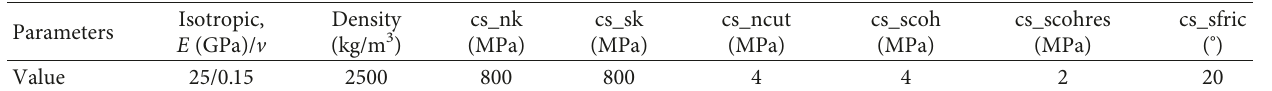
Table 1: Material parameters for the liner structural element.